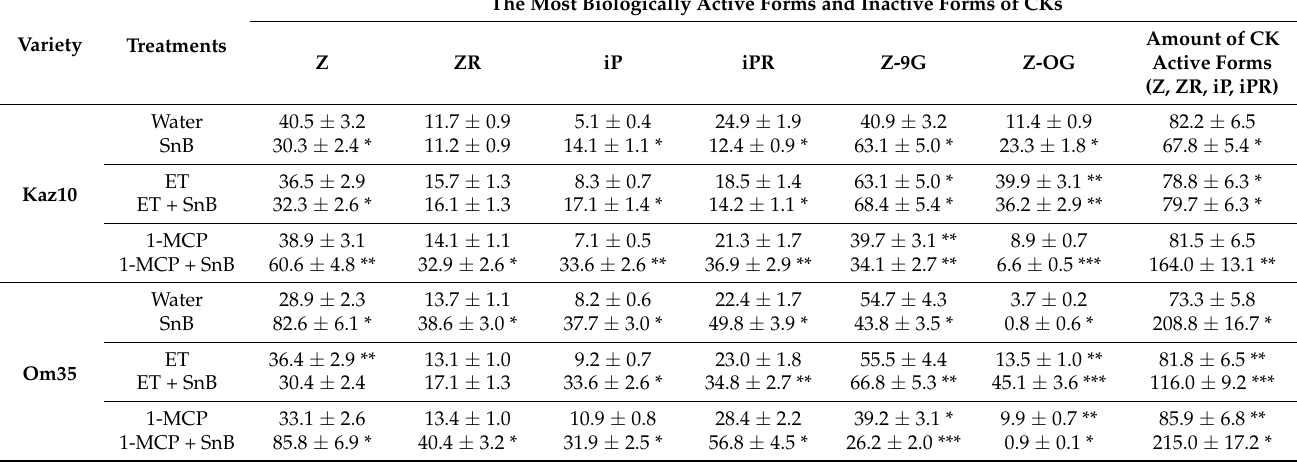
Table 1. The effects of pretreatment with ethephone (ET) and 1-MCP on the content of cytokinins (pmol/g FW) in leaves of two Omskaya 35 and Kazakhstanskaya 10 cultivars at 24 h after inoculation with virulent S. nodorum isolate SnB.